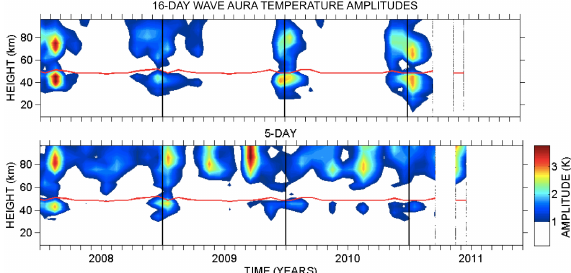
Fig. 12. Time-height contours of monthly-mean temperature amplitudes from 2008 – 2011 for the 16- and 5-day waves at a latitude of 35 – 45 ◦ N. Also plotted is the stratopause height (red contour line). Fig. 11. Planetary-wave amplitudes measured by the meteor radar (WIND) and Aura MLS (TEMP) for large-amplitude wave events or “bursts”.